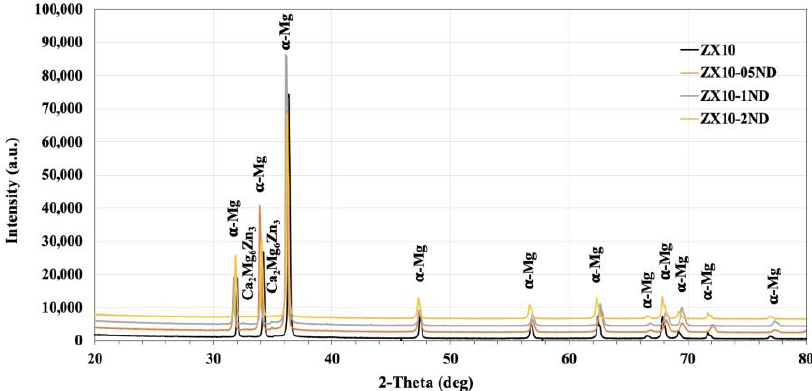
Figure 1. The X-ray diffraction analysis patterns of the alloy and nanocomposites.